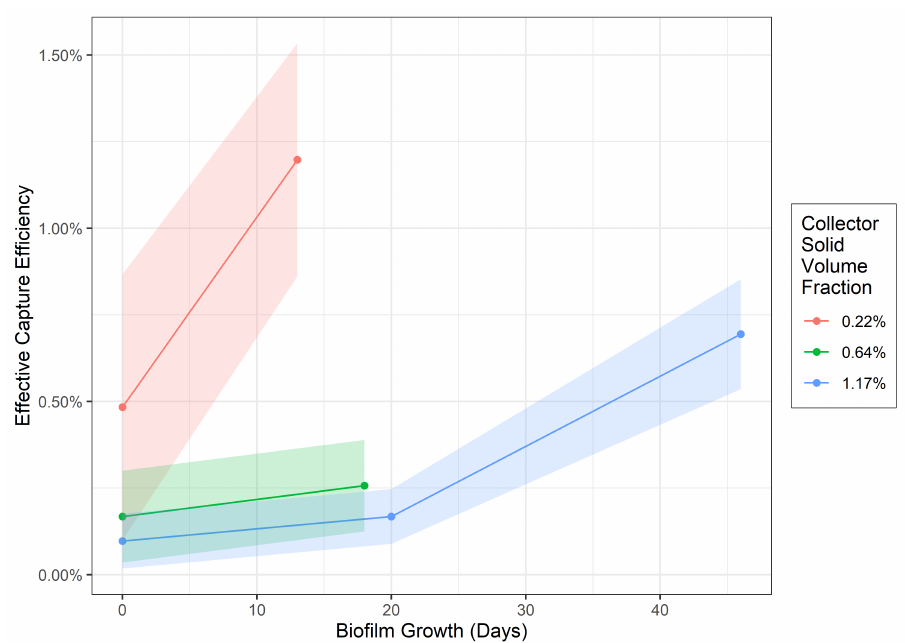
Figure 7. Estimates of effective capture efficiency calculated from experimental runs with varying degrees of biofilm growth. Colors represent the different collector densities, expressed as solid volume fraction ( φ c ). Straight lines connect the points that represent our experiments, and the shaded areas represent 95% confidence intervals for ECE inferred from our measurement uncertainty.